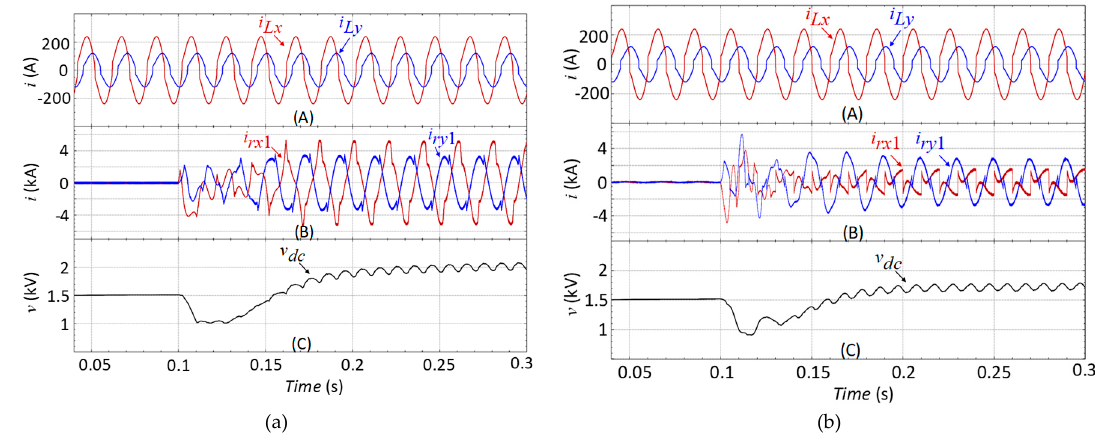
Figure 22. Simulation results of the FB-RPC in V/V traction power system ( a ) and in Scott traction power system ( b ) when the feeder section x has double the load of the feeder section y : (A) currents of the feeder sections; (B) compensation currents synthesized by the FB-RPC; and (C) DC-link voltage of the FB-RPC.